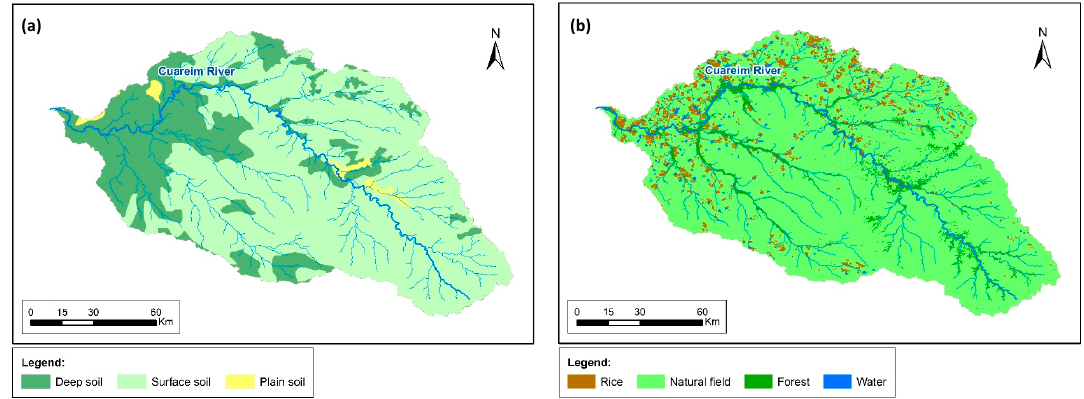
Figure 4. ( a ) Soil thickness, and ( b ) land-use categories in the study watershed.